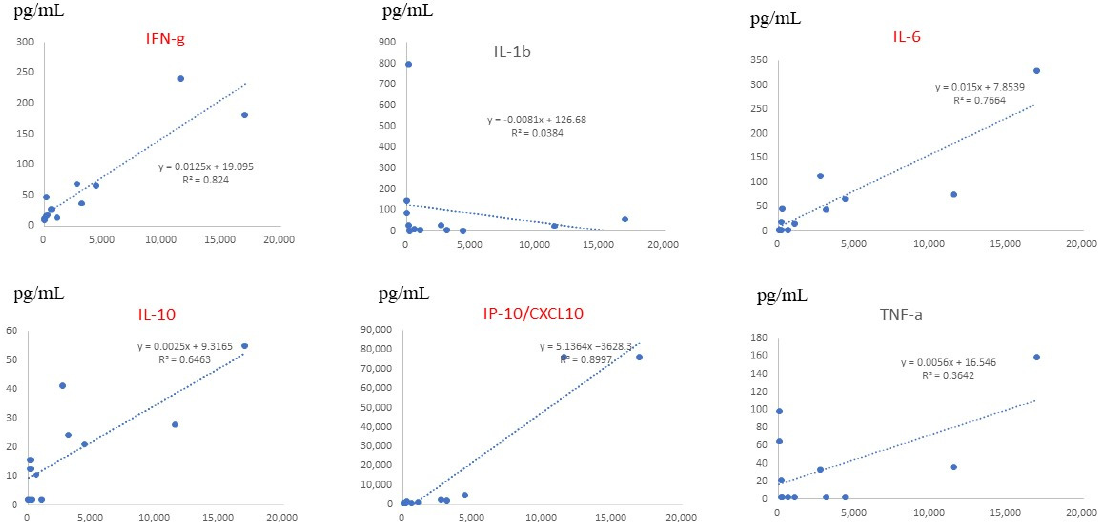
Figure 5. Comparison between serum fractalkine/CX3CL1 levels and inflammatory cytokine levels in patients with RSV infection. The horizontal lines ( x -axis) indicate the level of each cytokine, and the vertical lines ( y -axis) indicate CX3CL1 levels. R represents the Pearson R -correlation. IFN- γ , IL-6, IL-10, and CXCL10 showed statistically significant differences between each cytokine and frac- talkine/CX3CL1.